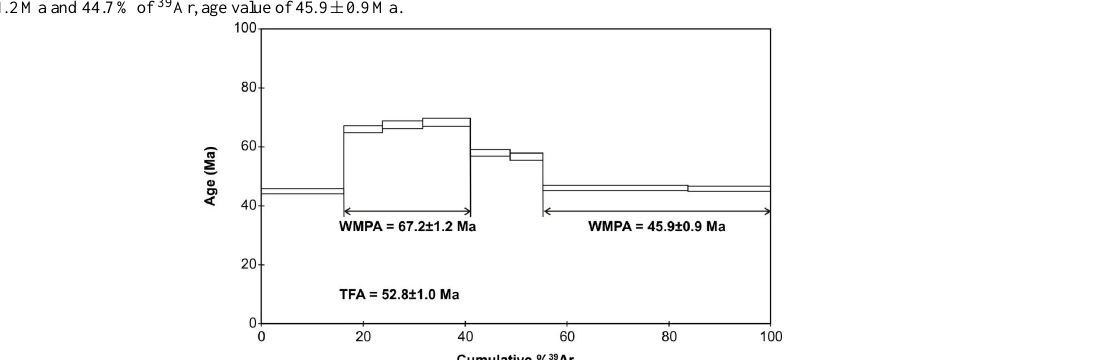
Age spectrum: the sample yielded complex age spectrum with noticeable hump after low temperature step containing three-steps intermediate plateau followed by high temperature two-steps intermediate plateau. Intermediate plateaus are characterized accordingly by 24.8% of 39 Ar, age value of 67 . 2 ± 1 . 2Ma and 44.7% of 39 Ar, age value of 45 . 9 ± 0 . 9Ma.